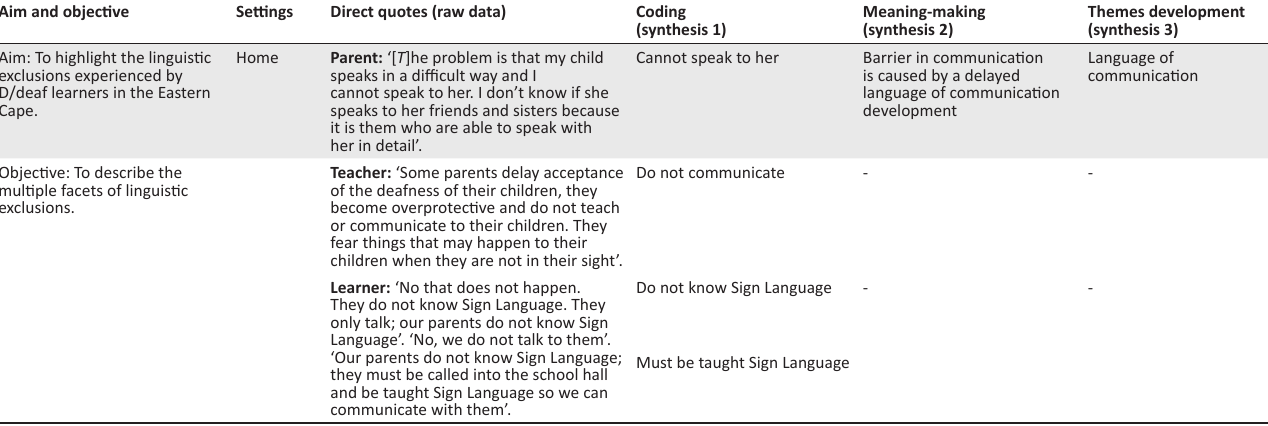
TABLE 1 : An example of themes developed during data analysis. Aim and